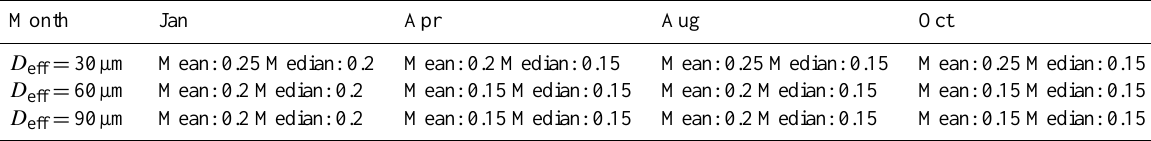
Table 1. Mean and median retrieved ice roughness for all 4 days of data and three effective diameter sizes.